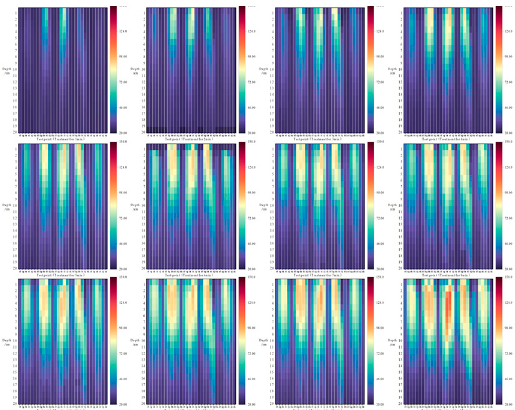
Figure 20. Heatmap of the internal temperature of 20% loess under microwave irradiation.